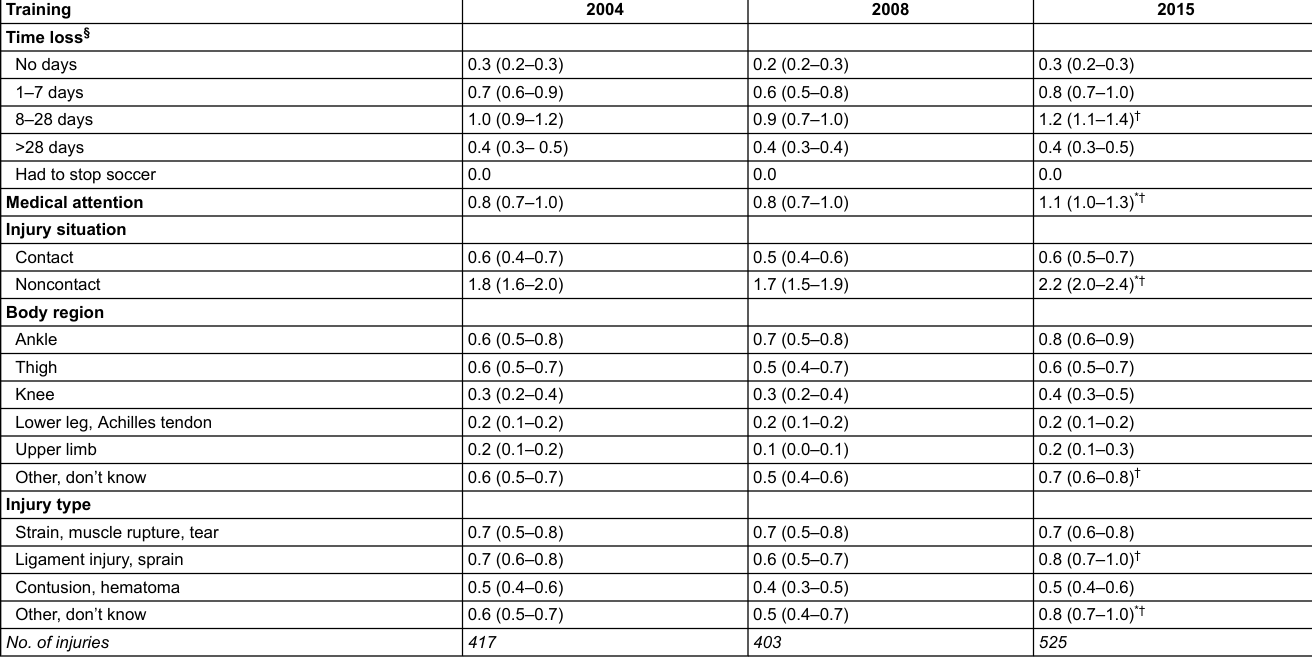
Table 4: Injury incidence in amateur soccer training per 1000 hours of playing during the previous 4 weeks, by causes and characteristics (including 95% confidence